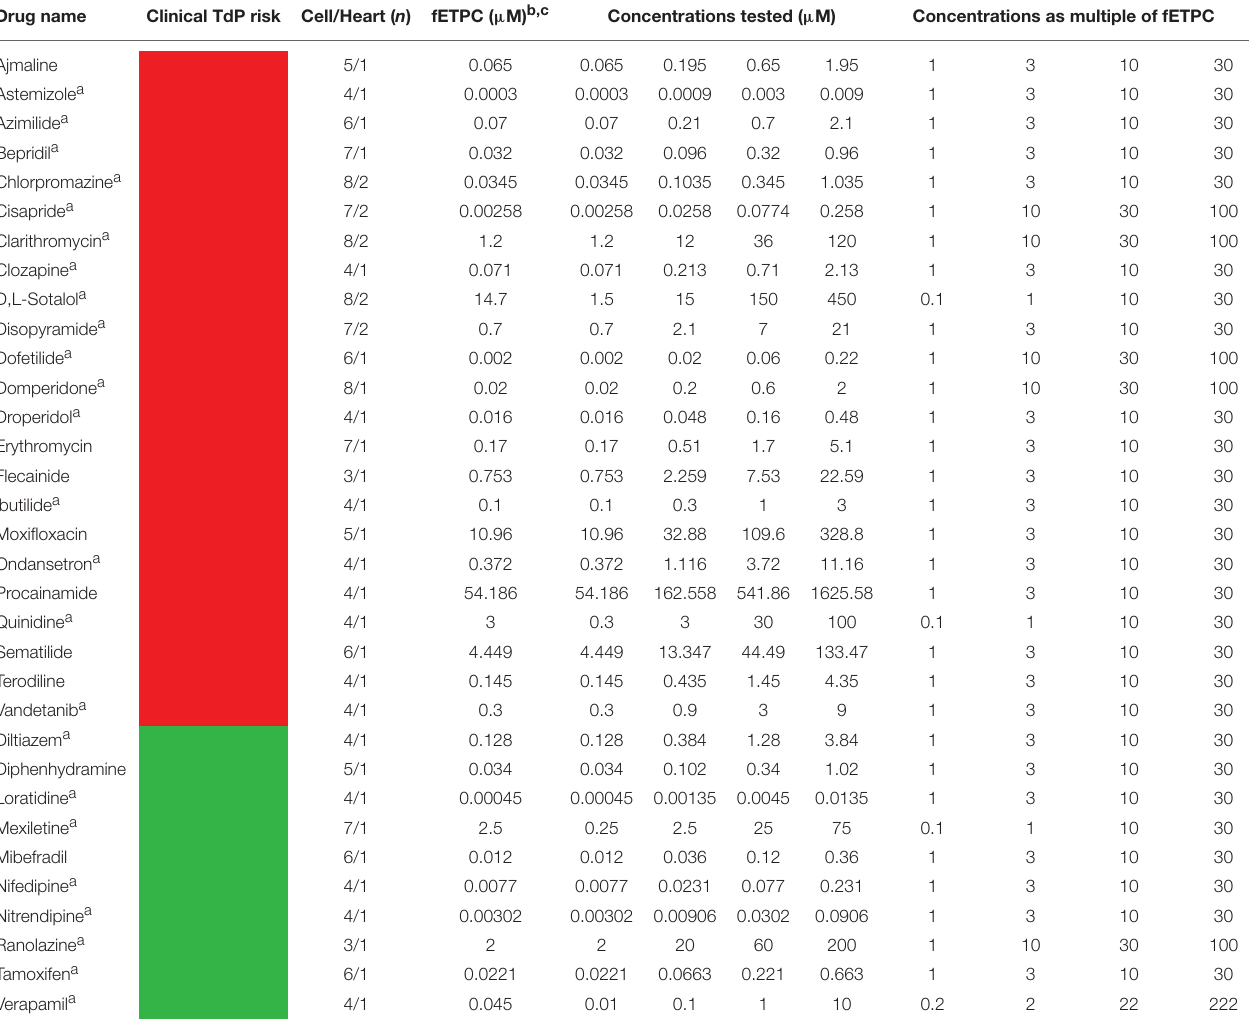
TABLE 2 | Concentrations tested in adult human primary cardiomyocyte-based model and ratio to clinical